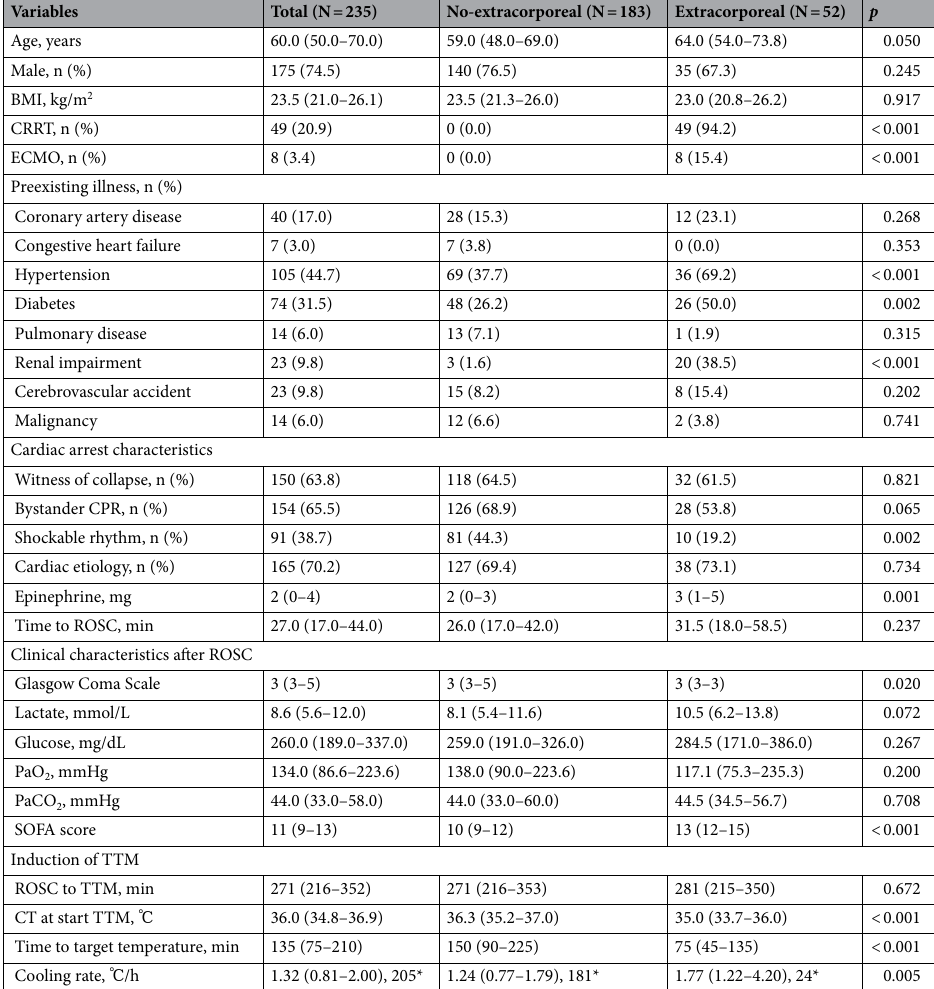
Table 1. Comparison of baseline characteristics according to the use of extracorporeal devices. Categorical variables were expressed as frequencies with percentages and continuous variables were expressed as medians with interquartile ranges. BMI body mass index, CRRT continuous renal replacement therapy, ECMO extracorporeal membrane oxygenation, CPR cardiopulmonary resuscitation, ROSC return of spontaneous circulation, SOFA sequential organ failure assessment, TTM targeted temperature management, CT core temperature. *included number for analysis.